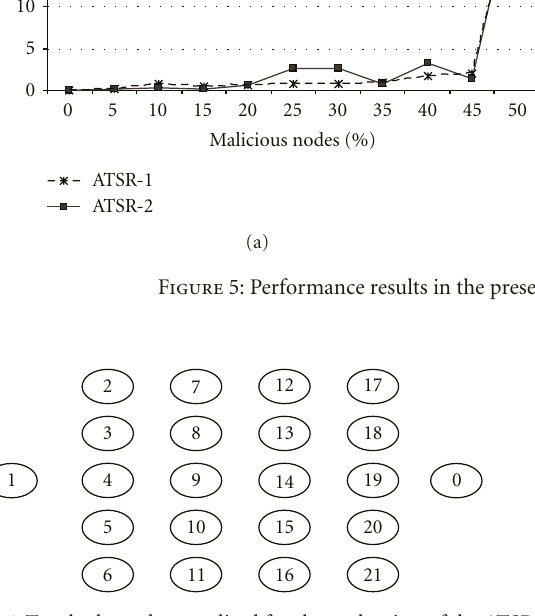
Figure 6: Test-bed topology realised for the evaluation of the ATSR